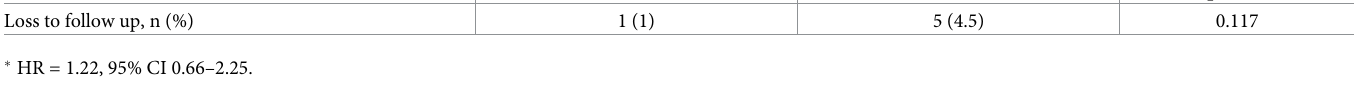
PLOS ONE | https://doi.org/10.1371/journal.pone.0251384 May 12,